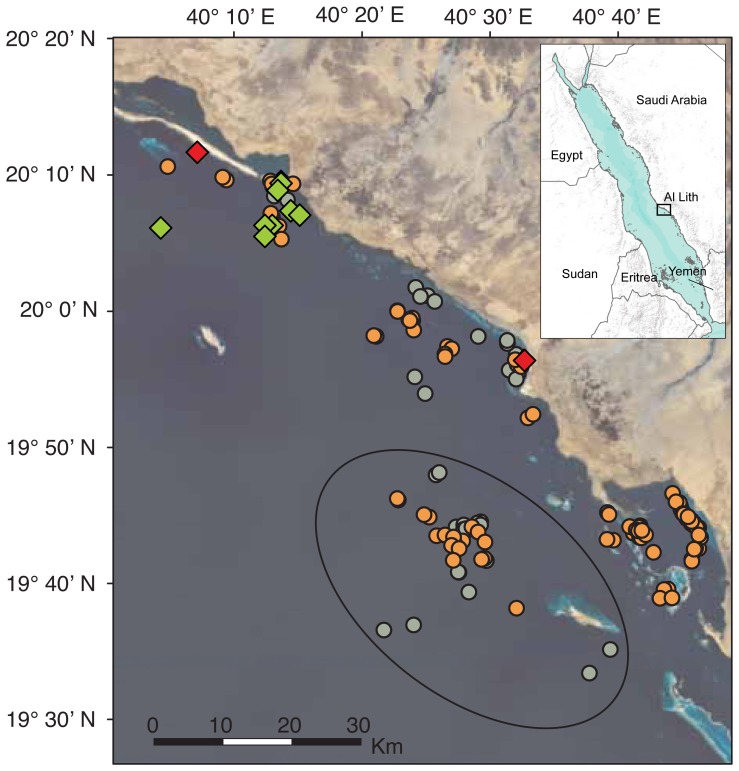

Manta alfredi tagging locations and habitat characterization.Locations for MA111 (orange) and MA112 (grey-green). Black oval indicates the locations characterized as “offshore” (>15 km from the coast). Green triangles indicate tagging locations for all individuals and red diamonds indicate pop-off locations for MA111 and MA112. Inset: Location of study site near Al Lith in the eastern Red Sea. Sources: Bing, U.S. Geological Survey, and ESRI.